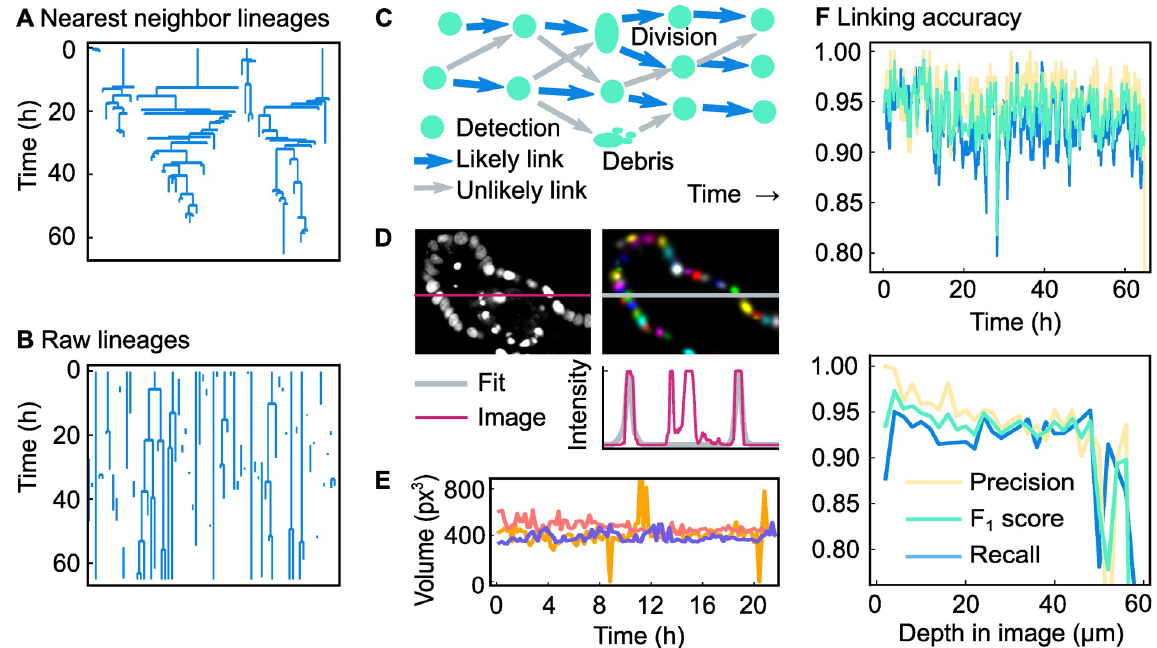
Fig 4. Overview and results of the linking algorithm. ( A ) Lineage trees obtained by linking using the nearest-neighbor method. ( B ) Raw lineage trees obtained by our linking algorithm. ( C ) Example of a network of links. There are many possibilities to link the cell detections in different time points together. Of all possible links (displayed as arrows), the most likely ones (displayed as blue arrows) are selected using a scoring system. ( D ) Original microscopy image, Gaussian fit and intensity profile of both. The intensity profile runs along the marked row in the image. We have chosen a section that highlights the fact that our approach can select nuclei and ignore cell debris, even though both have a similar fluorescence intensity profile. ( E ) Nucleus volume of three nuclei extracted from a Gaussian fit. The volume ( V = Cov( x , x ) � Cov( y , y ) � Cov( z , z )) is calculated for three non-dividing cells. The outliers are caused by errors in the Gaussian fit. ( F ) Accuracy of the linking algorithm presented here for a single organoid, over time and over the image depth. Note that the precision is higher than for nearest-neighbor